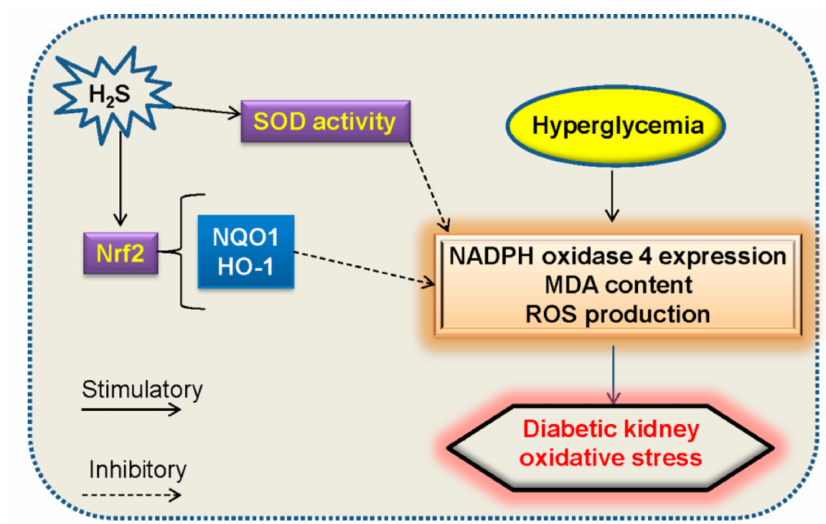
Figure 4. E ff ects of H 2 S on oxidative stress in diabetes kidney disease. H 2 S is found to reduce high glucose-induced oxidative stress by activating the Nrf2 antioxidant pathway and two downstream targets of Nrf2, HO-1 and NQO1, as well as enhancing the SOD and glutathione peroxidase activities in diabetes kidney disease. Nrf2, nuclear factor erythroid-2 related factor 2; HO-1, heme